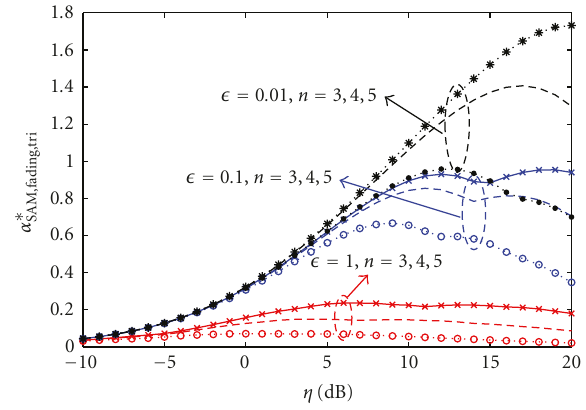
Figure 6: The ( p , q )-optimized α SAM,fading,tri in bits-meters/s/Hz/ node versus η for the triangular topology under SNR 0 = 30dB and ρ =